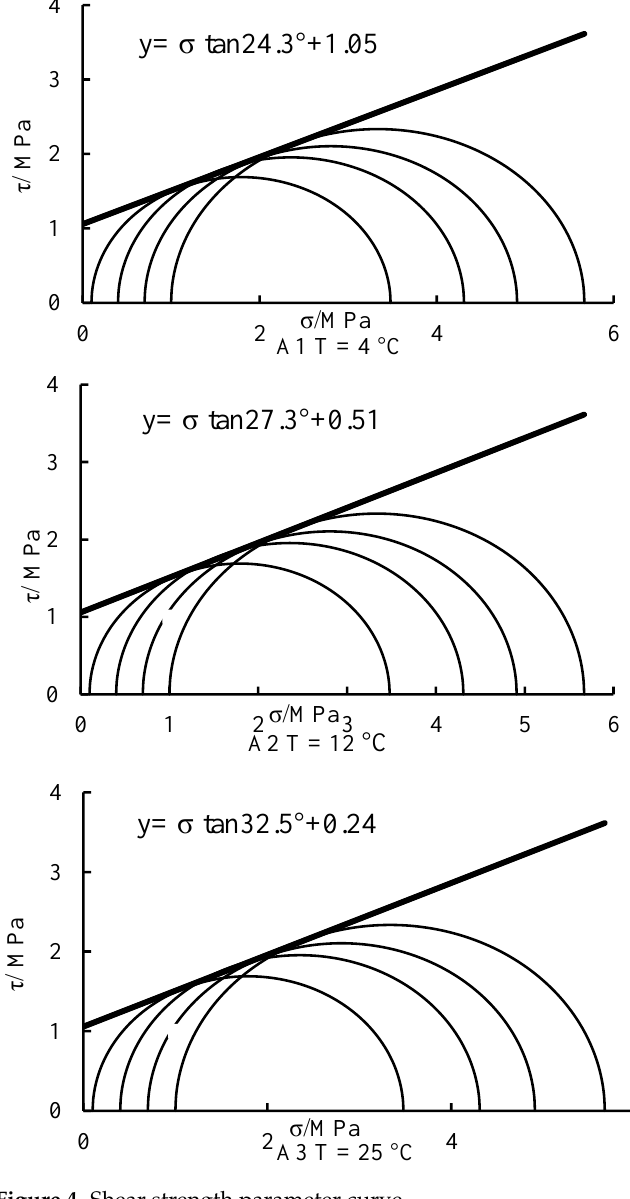
Figure 4. Shear strength parameter curve.